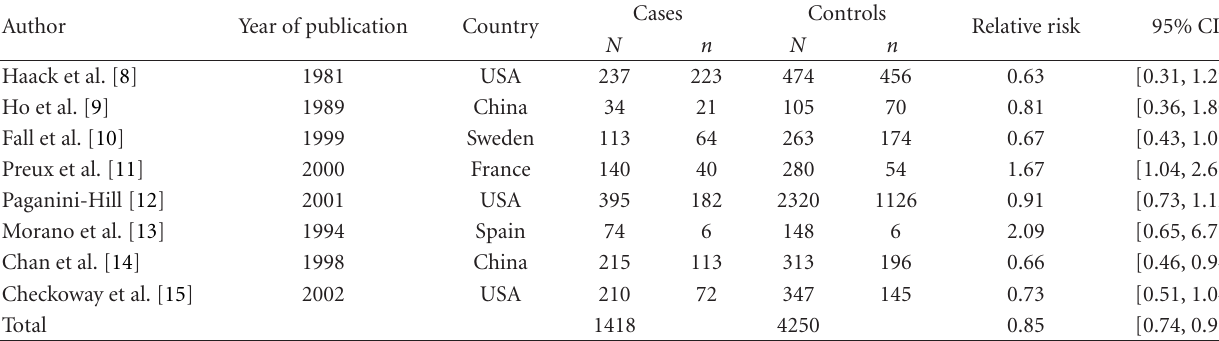
Table 1: Tea drinking and PD risk.